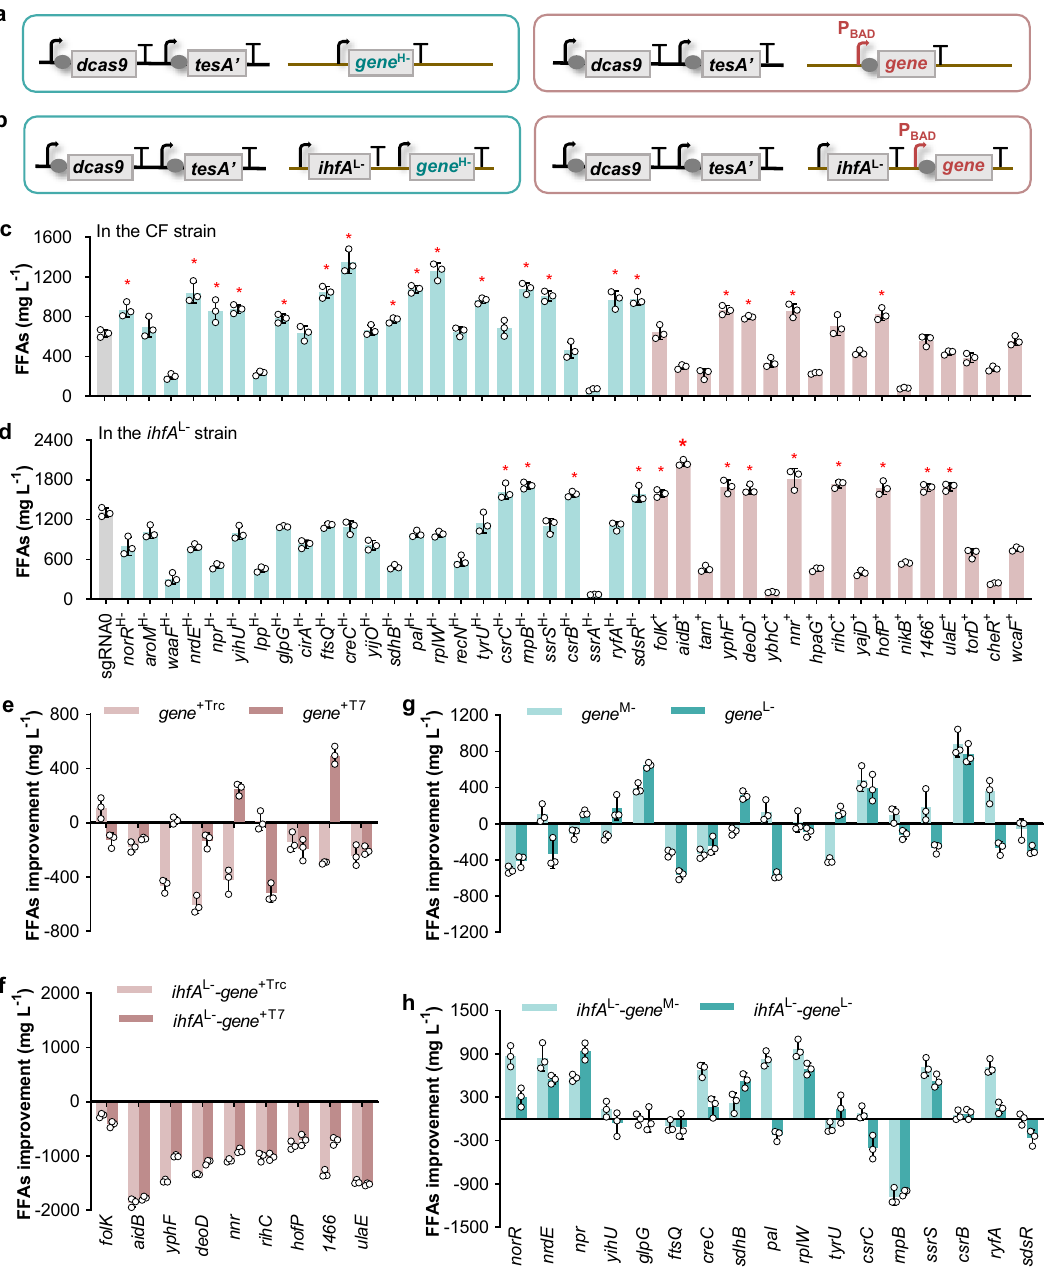
Fig. 5 Reverse engineering of the candidate targets derived from omics analyses for identi fi cation of bene fi cial genes and tuning of gene expression for enhanced FFAs production. Schematic of cassettes used to repress or overexpress the target genes in the CF strain ( a ), or in the ihfA L − strain ( b ). High repression was achieved by applying sgRNA gene H − , and overexpression was enabled by the P BAD promoter. TesA ′ , dCas9, and sgRNAs were controlled by the P T7 , P Trc , and P R promoters, respectively. Effect of perturbation of the target genes on FFAs production in the CF strain ( c ) or in the ihfA L − strain ( d ). Asterisk represents the strain in which the FFAs titer increased by over 20% compared with that in the reference strain in each bar chart, and the targeted genes are referred to as bene fi cial genes. Effect of tuning the expression of bene fi cial genes on FFAs production in the CF strain ( e , g ) or in the ihfA L − strain ( f , h ). The overexpression was tuned by utilizing the P Trc or P T7 promoter, and the repression was tuned by applying the sgRNA gene M − or gene L − . Red bar, overexpression; green bar, repression. The titers were obtained in batch cultivation of 30 g L − 1 glycerol. Data are presented as mean ± SD ( n = 3 biological replicates). Source data underlying ( c – h ) are provided as a Source Data fi